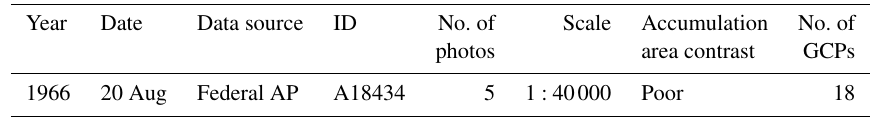
Table 7. Aerial photographs used.